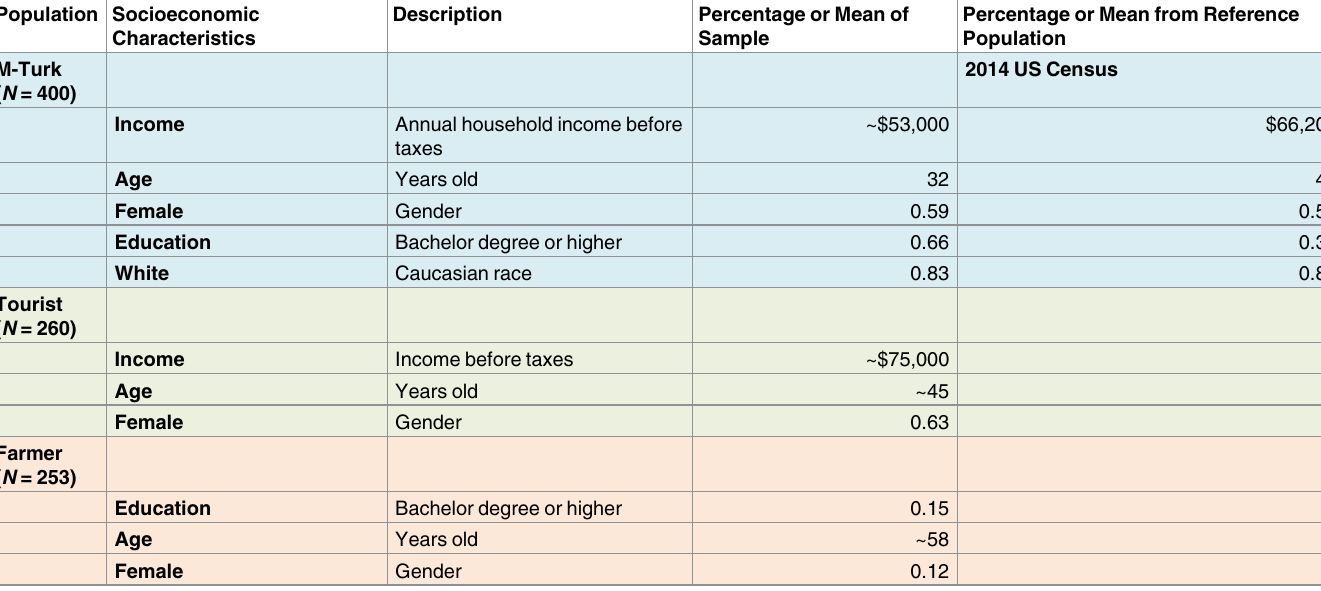
Table 2. Demographic characteristics of our three samples. Population Socioeconomic